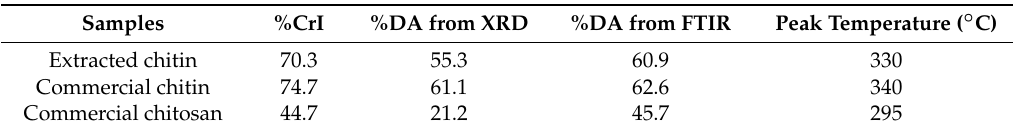
Figure 3. Fourier transform infrared (FTIR) spectra of crab shell ( a ), extracted chitin ( b ), commercial chitin ( c ), and commercial chitosan ( d ).